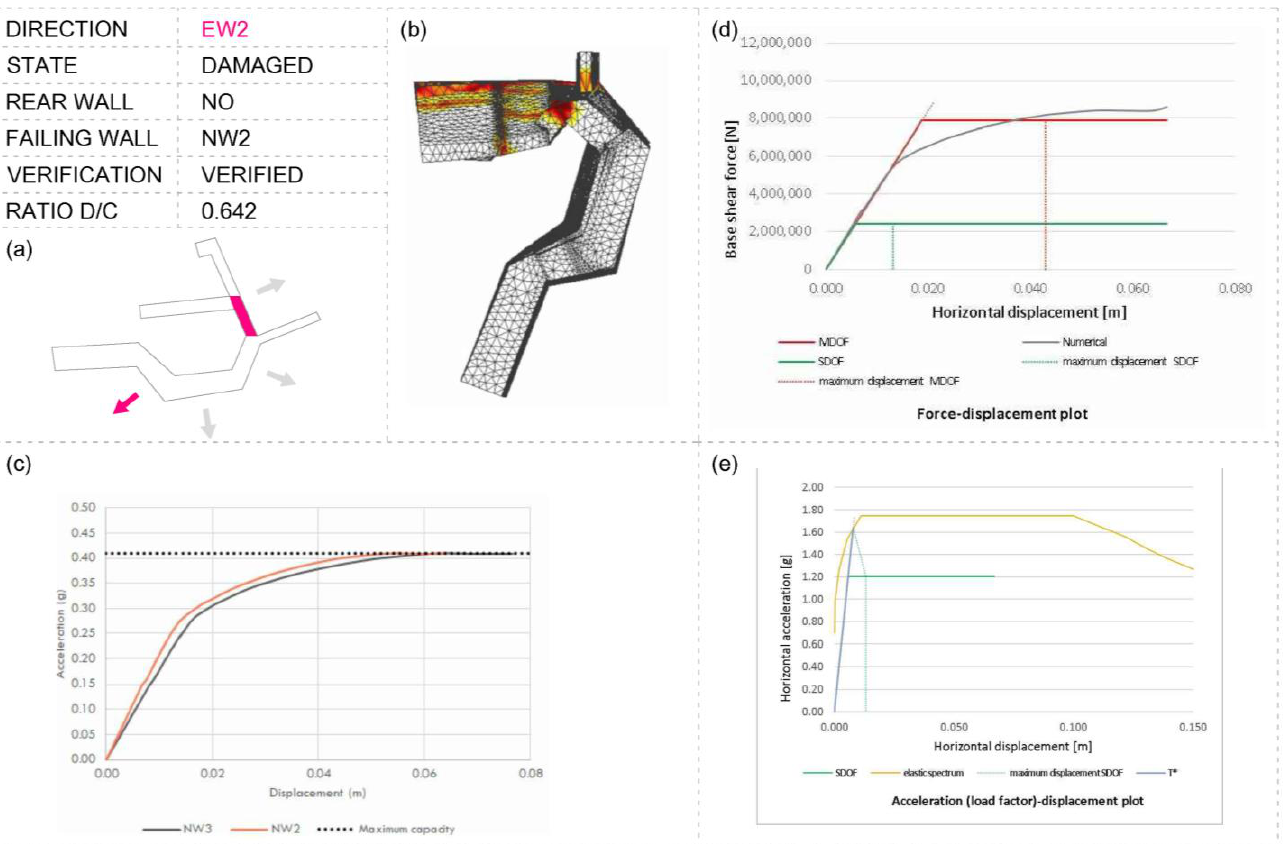
Figure 24. Location of the most vulnerable walls and loading directions.